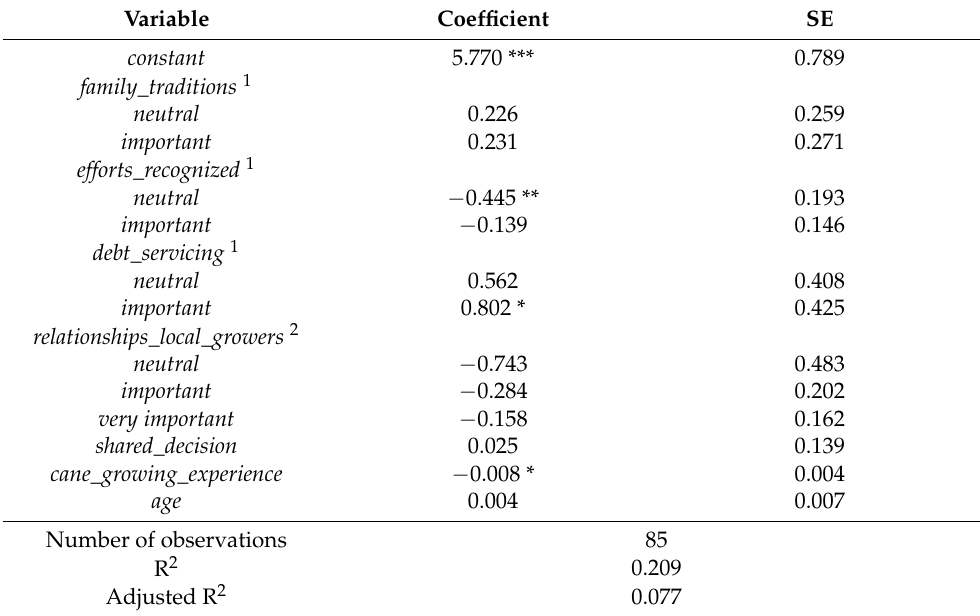
Table 4. Ordinary least squares regression results. Dependent variable: